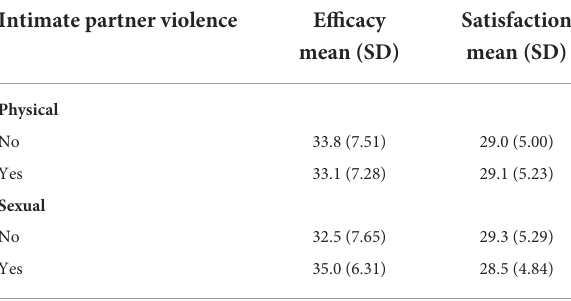
TABLE 5 Mean difference parenting efficacy and satisfaction stratified by physical and sexual